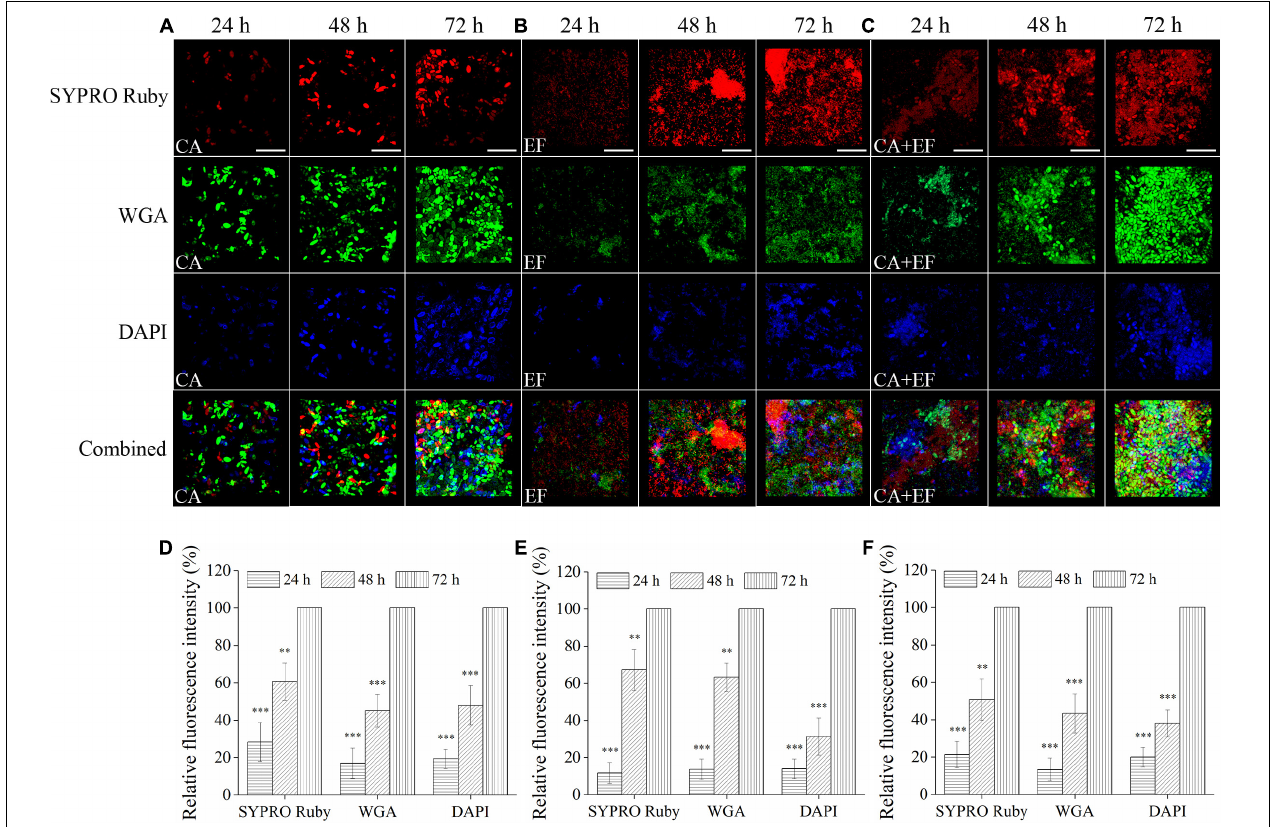
FIGURE 2 | The matrix component levels within biofilms of C. albicans SC5314 (CA) (A) and E. faecalis 20033 (EF) (B) single and dual species (CA + EF) (C) at 24, 48, and 72 h were observed by confocal laser scanning microscope (CLSM) (scale bars of 20 µ m). Extracellular proteins, polysaccharides, and eDNA inside biofilms were stained with SYPRO Ruby (5 µ g/ml), wheat germ agglutinin conjugated with Alexa Fluor TM 488 Conjugate (WGA) (5 µ g/ml), and 4 (cid:48) ,6-diamidino-2-phenylindole (5 µ g/ml), respectively. The excitation/emission wavelengths were 450/610 nm for SYPRO Ruby, 495/519 nm for WGA, and 358/461 nm for 4 (cid:48) ,6-diamidino-2-phenylindole (DAPI), respectively. The relative fluorescence intensity of matrix components within biofilms by C. albicans SC5314 (D) , E. faecalis 20033 (E) , and dual species (F) in different growth stage groups was calculated and plotted against those of the 72-h cultivation group using Image-Pro Plus 6.0 software, respectively. Scale bars represent the standard deviation (SD) ( n = 3). ∗∗ p < 0.01; ∗∗∗ p <